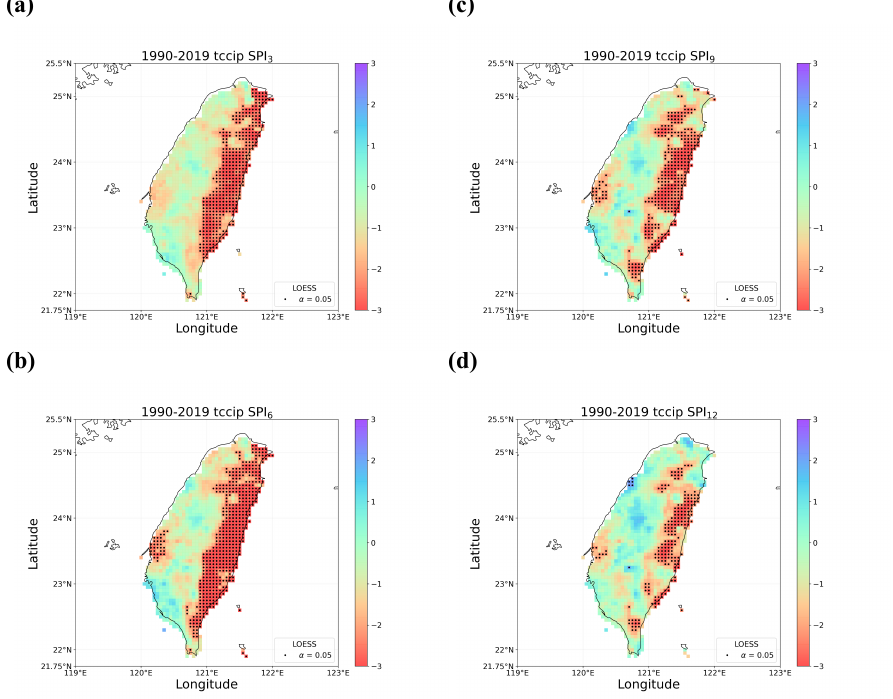
Figure 12. The same as Figure 10, but for detected trends using